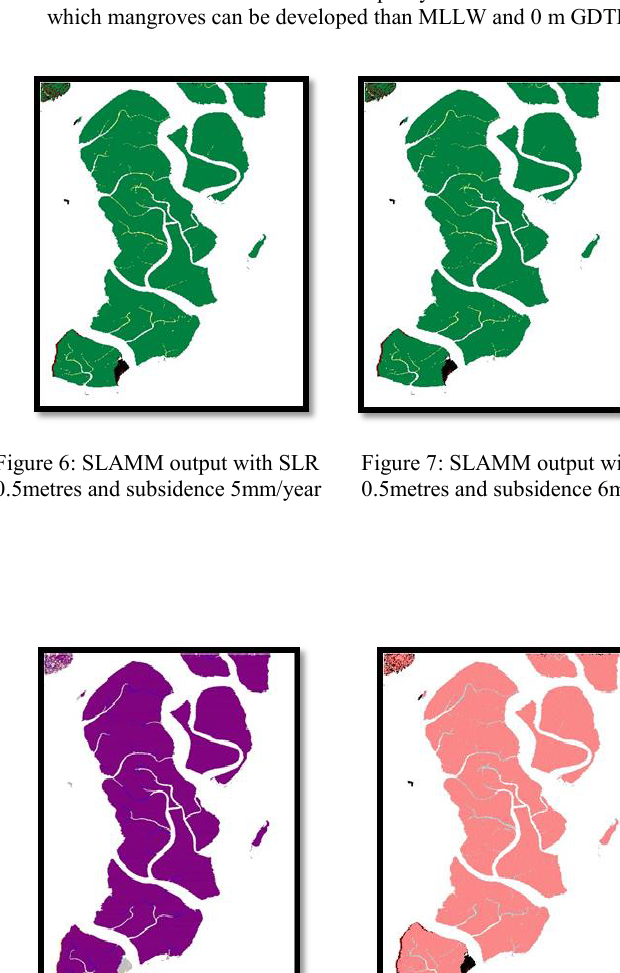
Figure8: SL AMM output with SLR 1 me ter and subsidence 5mm/year